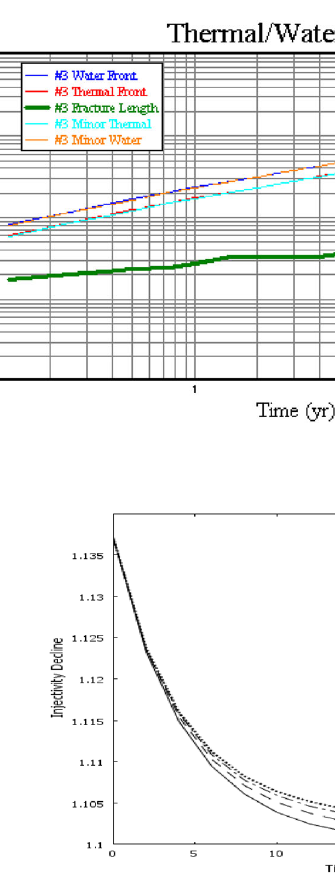
Fig. 19 PERFTOP case thermal and fracture profiles